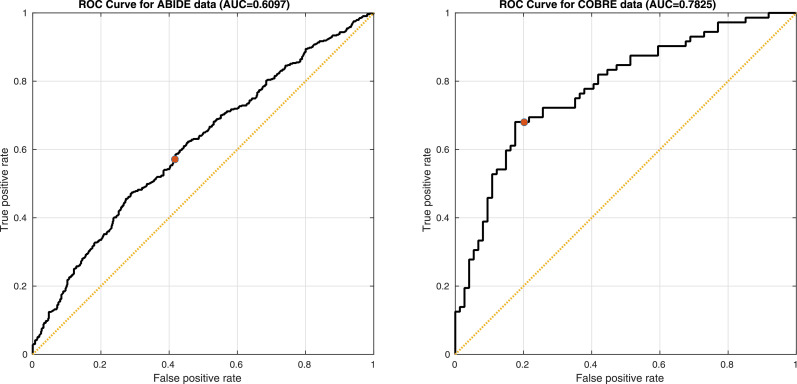
ROC curves from five-fold cross-validation accuracies from the ABIDE and COBRE data. Red dots show the point on the curve where the classification gives probabilities of 0.5.